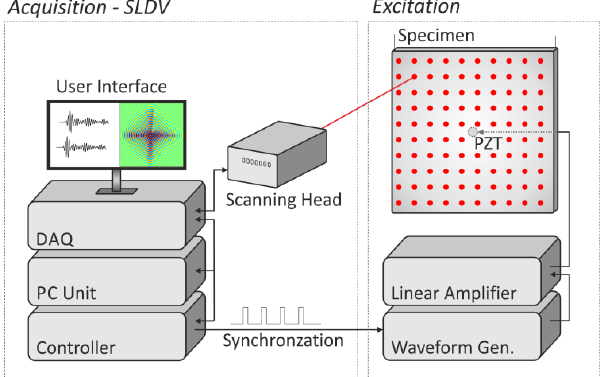
Figure 4. Experimental set-up.